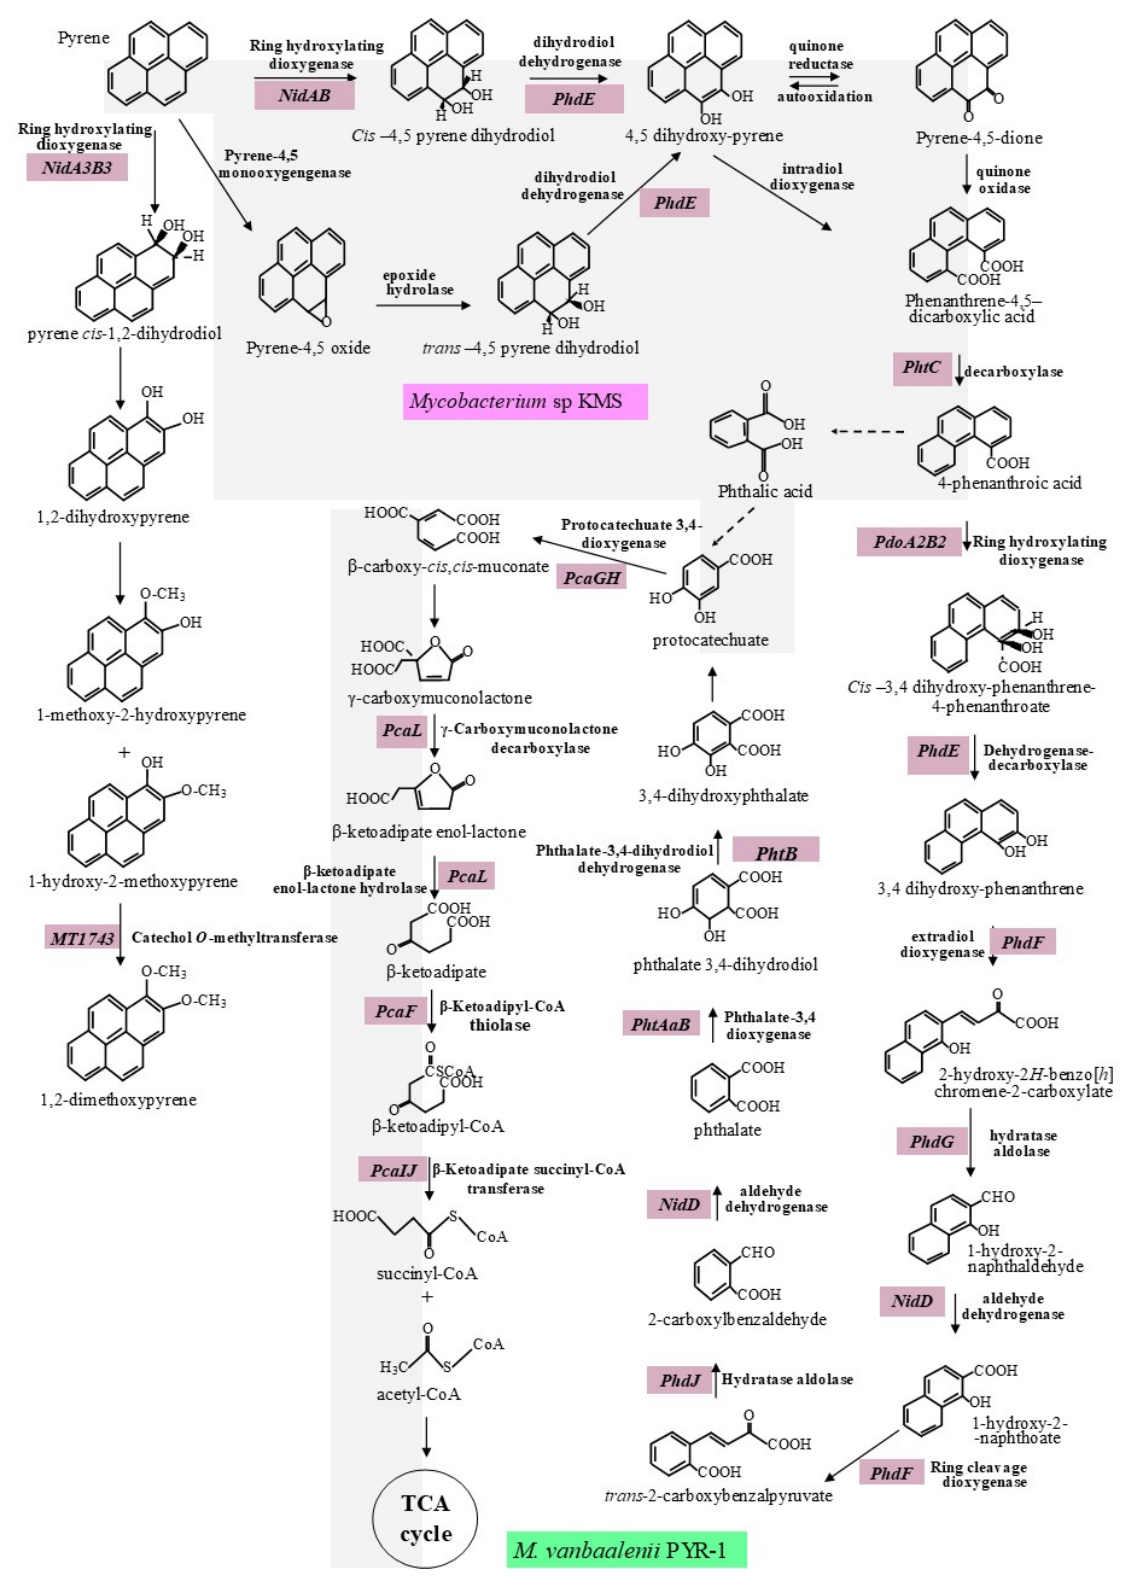
Figure 1. Complete aerobic pyrene degradation pathway by M. vanbaalenii PYR-1 (no color side) and Mycobacterium sp. KMS (the colored one). The half colored steps are shared by the two strains. Solid and dashes arrows represent single and multiple steps, respectively (adapted from Liang et al. [43] and Kim et al. [20]).